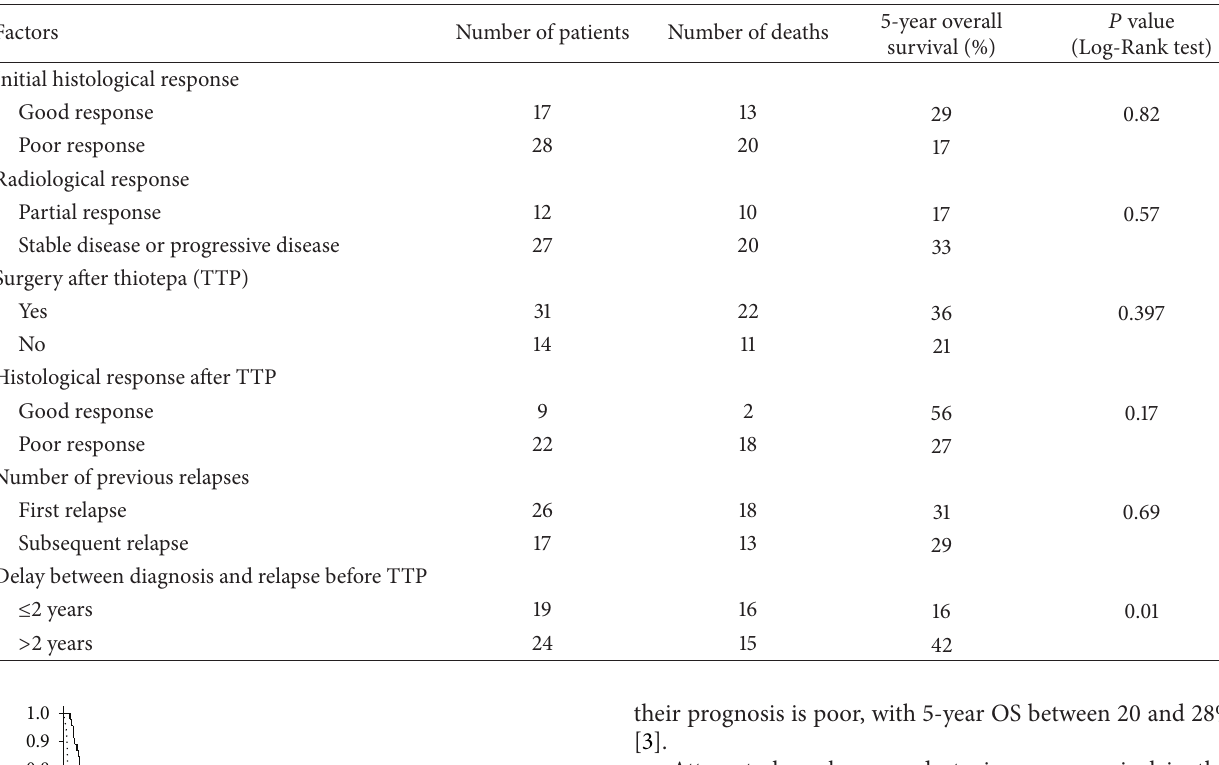
Table 3: Univariate analysis.